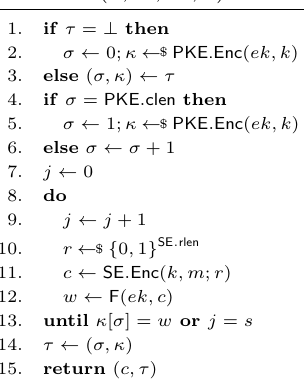
Figure 7: Our type 1 asymmetric ASA on symmetric